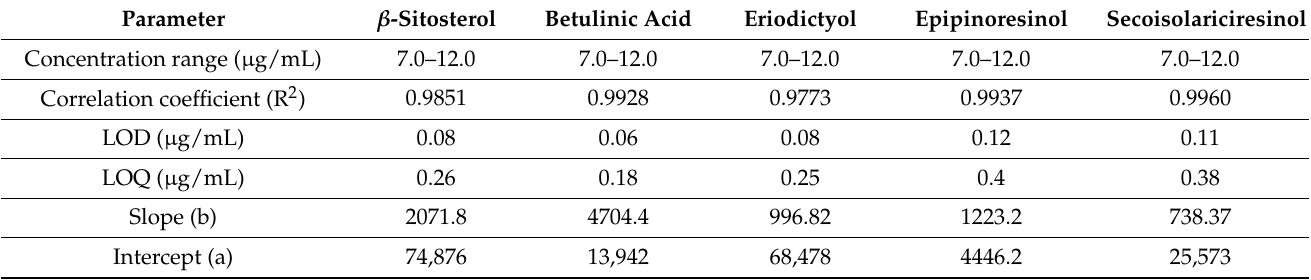
Table 1. Analytical parameters for β -sitosterol, betulinic acid, eriodictyol, epipinoresinol, and secoiso- lariciresinol using the proposed GC-MS/MS